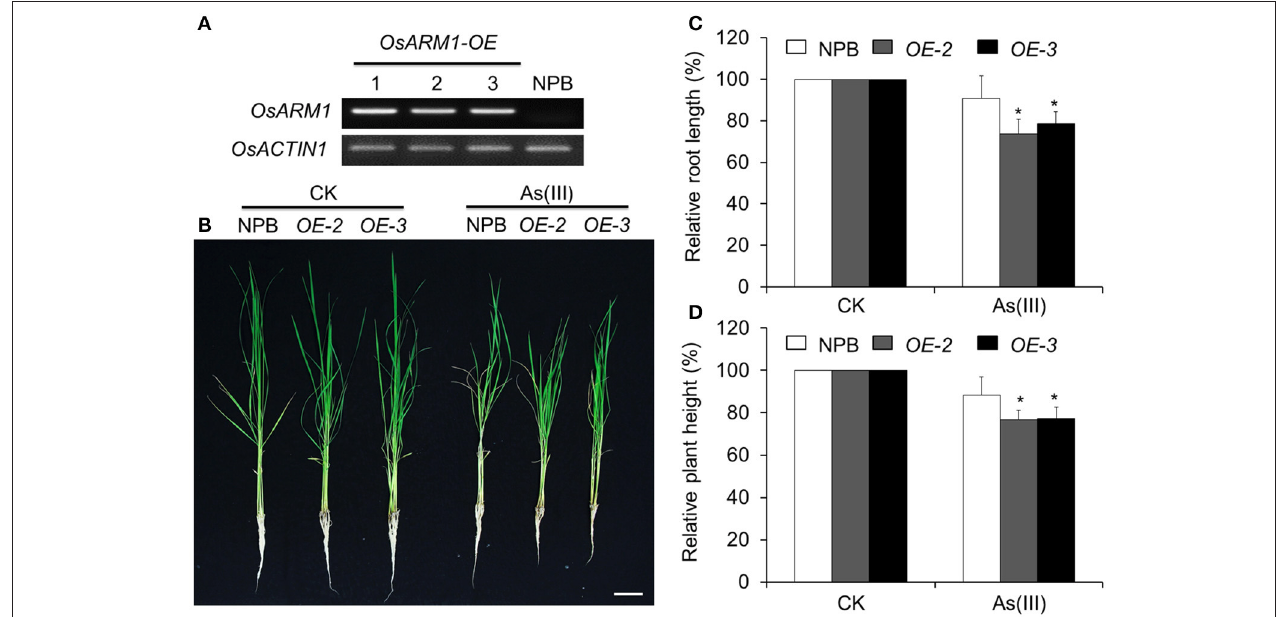
FIGURE 5 | Overexpression of OsARM1 attenuates tolerance to As(III). (A) The expression levels of OsARM1 in the OsARM1-OE transgenic lines were determined by RT-PCR analysis. OsACTIN1 was used as a reference gene. (B) Images of wild-type NPB and OsARM1-OE transgenic lines ( OE-2 and OE-3 ) treated without (CK) or with As(III). Two-week-old seedlings were grown on Kimura B medium or Kimura B medium containing 25 µ M As(III) for 7 days. Bars = 4 cm. (C,D) Relative root elongation (C) and relative plant height (D) of NPB and OsARM1-OE transgenic lines ( OE-2 and OE-3 ) after As(III) treatment. The experiments were repeated three times (biological replicates), and > 10 plants were used for each genotype in a single experiment. Data are means ± SD ( n = 30) calculated from three independent experiments. Asterisks indicate significant differences from wild type (* P < 0.05 by Student’s t